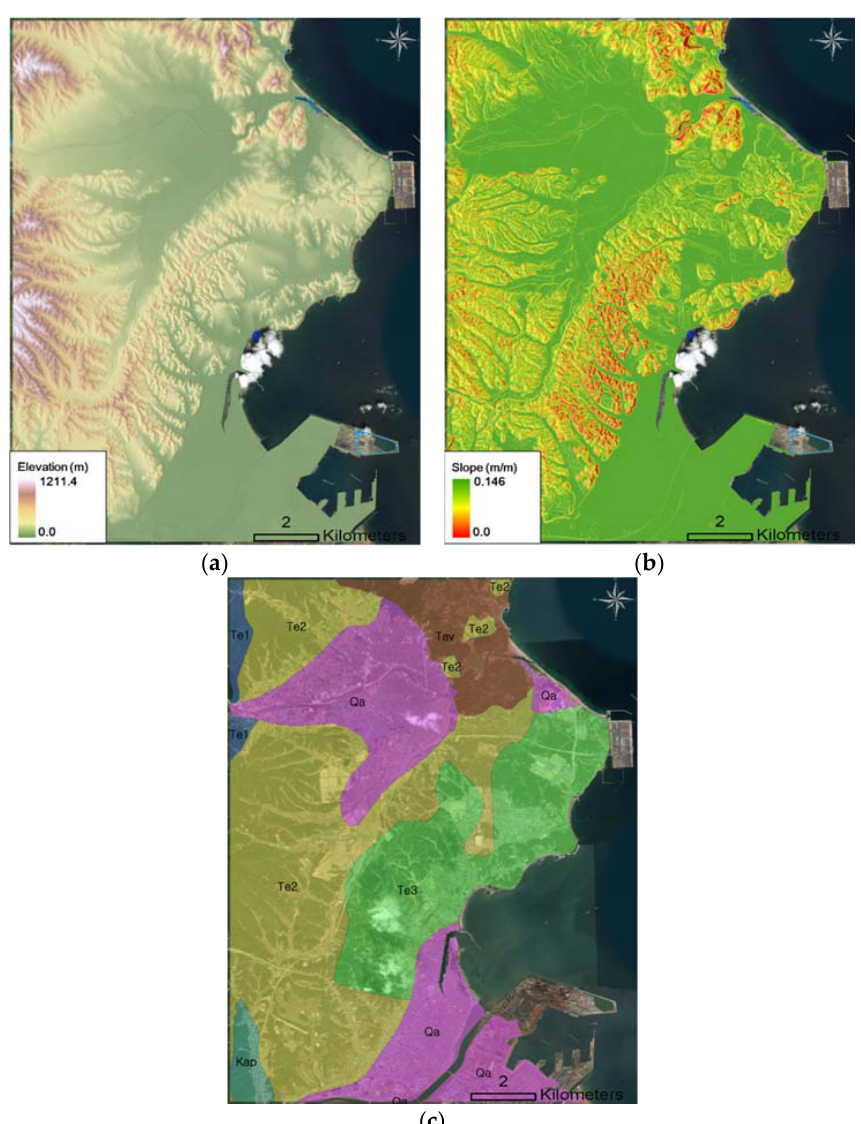
Figure 4. Geospatial grid information of the representative surface datasets: ( a ) digital elevation model; ( b ) slope; ( c ) geological map.